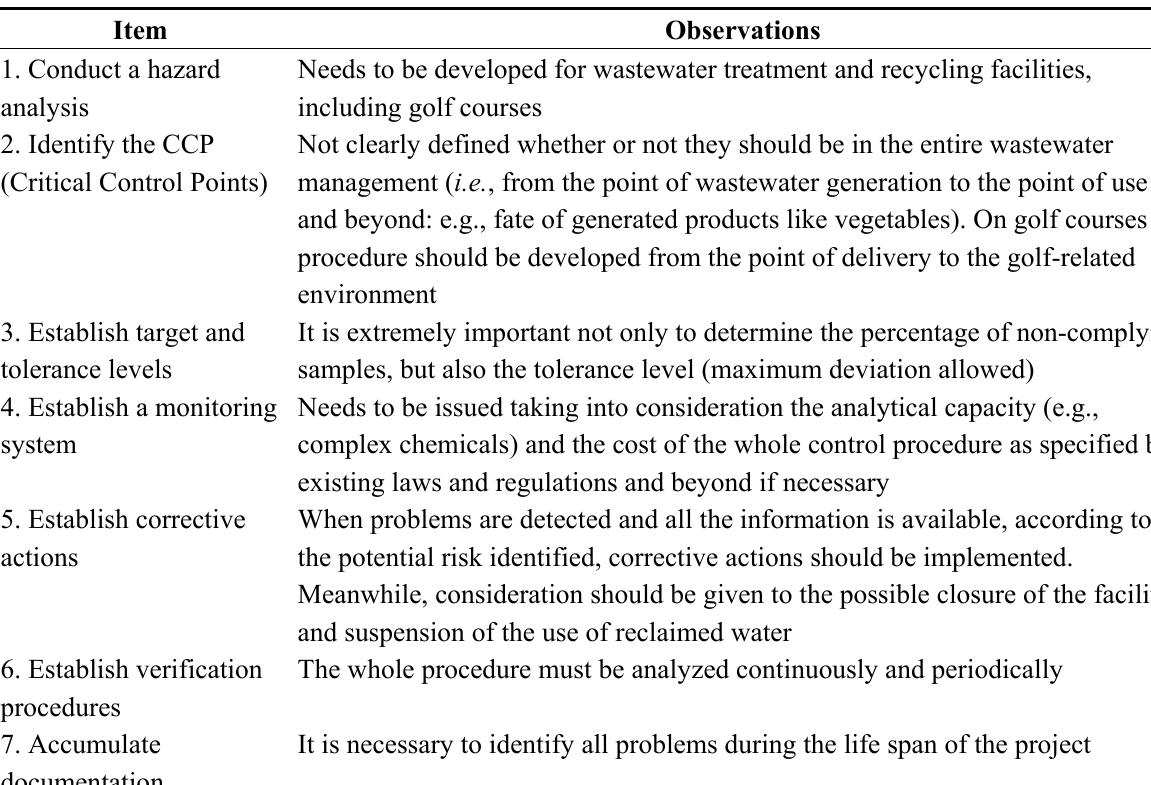
Table 13. The seven principles to be developed in Hazard Analysis and Critical Control Point (HACCP) systems.